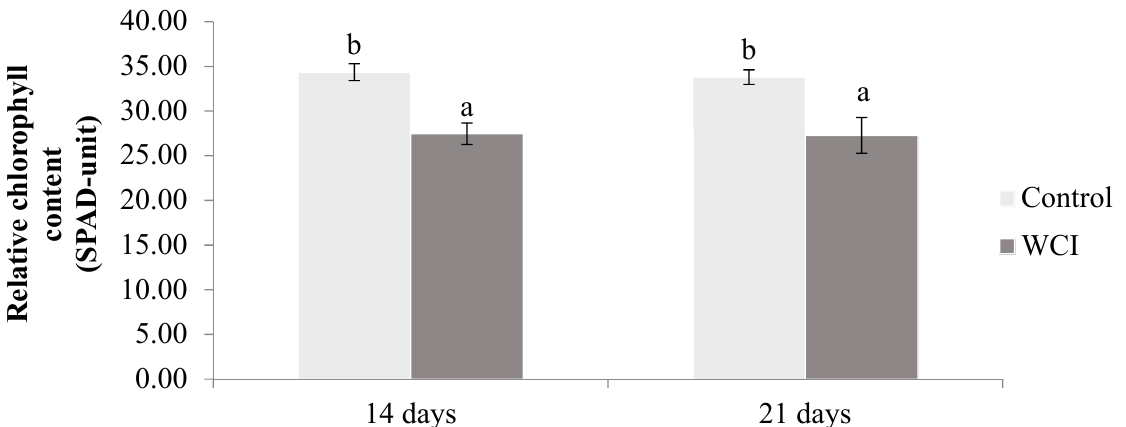
Figure 1. The effect of woolly cupgrass infestation (WCI) on the leaf relative-chlorophyll content of the fourth (14 d.a.s.) and fifth (21 d.a.s.) maize leaves (values represent means ± SD, n = 50). Small letters (a, b) show significant differences between treatments based on independent t -test ( p < 0.05).